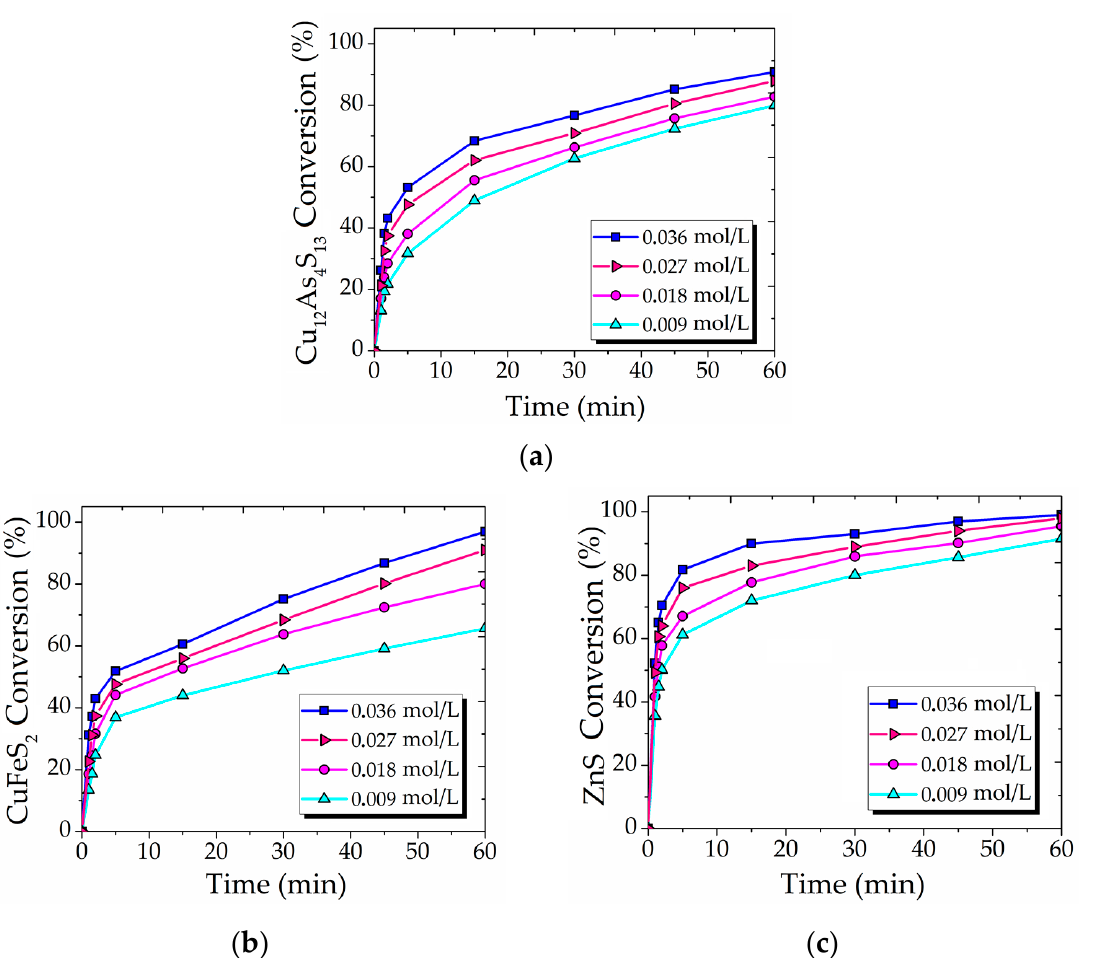
Figure 4. The effect of Fe (III) concentration on the conversion of Cu 12 As 4 S 13 ( a ), CuFeS 2 ( b ) and ZnS ( c ) (300 rpm; 353 K; 6 mol/L HNO 3 ; FeS 2 /synt. conc = 1/1).